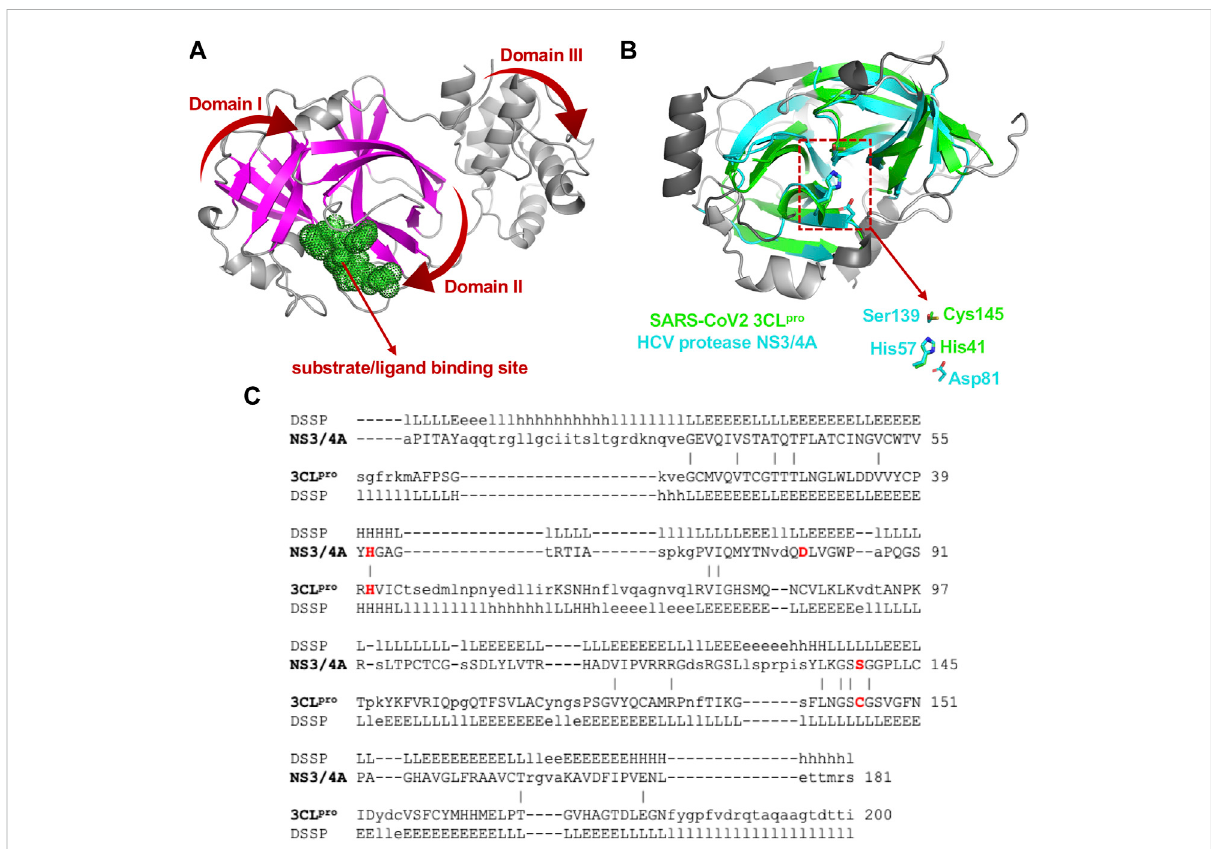
FIGURE 1 Structuralsuperimpositionandstructure-basedsequencealignmentsofSARS-CoV23CL pro andHCVNS3/4Aproteases. (A) Three-dimensional structures ofSARS-CoV2 3CL pro . The β -strandsforming thecharacteristic β -barrels are colored inmagenta.Other secondarystructureelements are shown as cartoon representation colored in gray. (B) The backbone structure of the SARS-CoV2 3CL pro , PDB 6Y2G (green) is superimposed on the backbone structure ofhepatitisC virus protease HCV NS3/4A,PDB 2P59 (cyan). The regions identi fi edby DALI server as structurally-analogous are shown incolor (green and cyan), and theregions that are not structurally-analogous are shown ingray.This superimposition ofbackboneatoms results in superimposition of the catalytic residues Cys145 and His41 of the SARS-CoV2 3CL pro with Ser139 and His57 of HCV NS3/4A protease. Residue Asp81 of the HCV protease catalytic triad is also shown. (C) Structure-based sequence alignment of HCV NS3/4A and SARS-CoV2 3CL pro . Catalytic residues of HCV NS3/4A (His57, Asp81 and Ser139) and SARS-Cov2 3CL pro (His41 and Cys145) are highlighted in bold red. Three-state secondary structure de fi nitions (H = helix, E = sheet, L = coil) are shown for each amino acid sequence. Structurally equivalent residues are in uppercase,structurallynon-equivalentresidues(e.g.inloops)areinlowercase.Identicalaminoacidsaremarkedbyverticalbars.AdaptedfromBafna et al.,